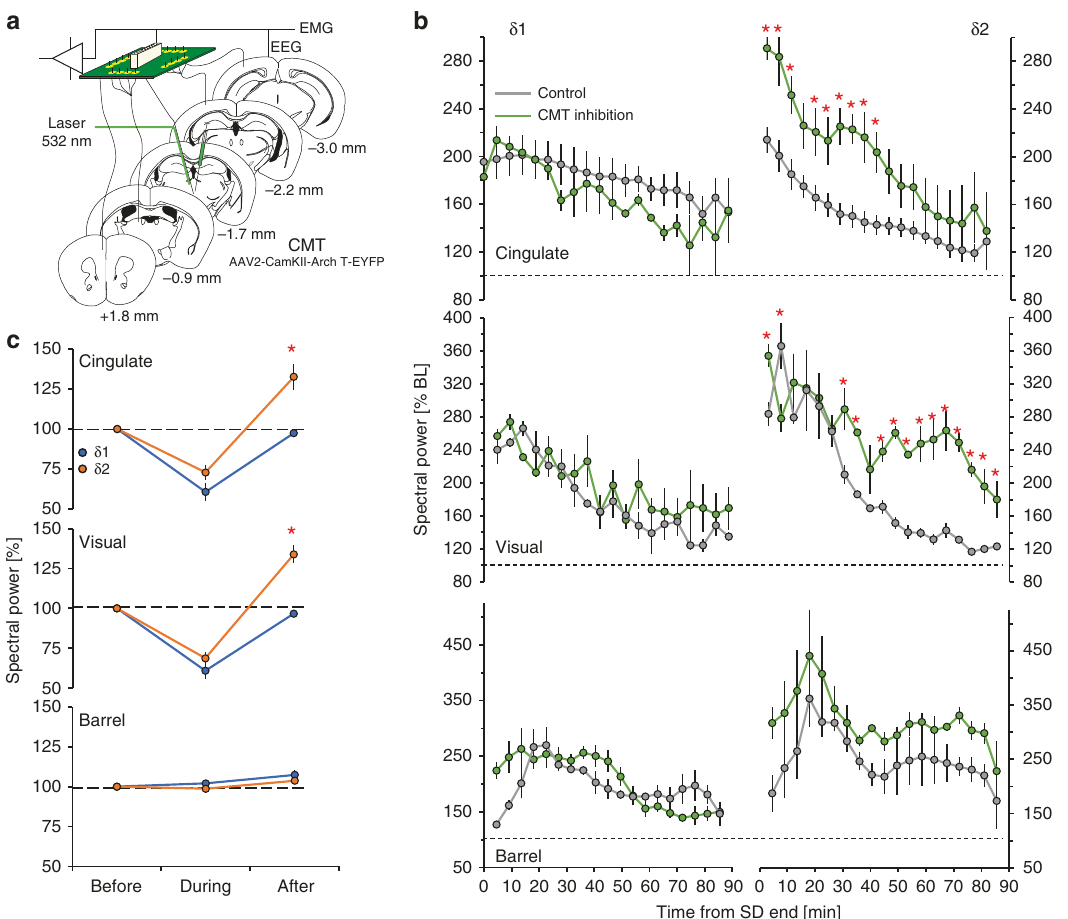
Fig. 5 Thalamic silencing alters δ 2-dynamics in cingulate and visual cortex. a Schema showing optogenetic inhibition of the CMT. Certain elements were re-used from a previous publication by the same authors 30 . b increased δ 2-power (right) during NREMS (green) following a 4-h SD in the cingulate (top) and visual (middle) cortices, but not the barrel cortex (bottom) as compared to control SD animals (gray) (two-way rANOVA factors silencing × time; cingulate: F 18,108 = 2.4, p = 0.003; visual: F 18,108 = 4.7, p = 1.8E-07). δ 1-power (left) was unaffected in all structures by CMT silencing. c Mean δ 1- and δ